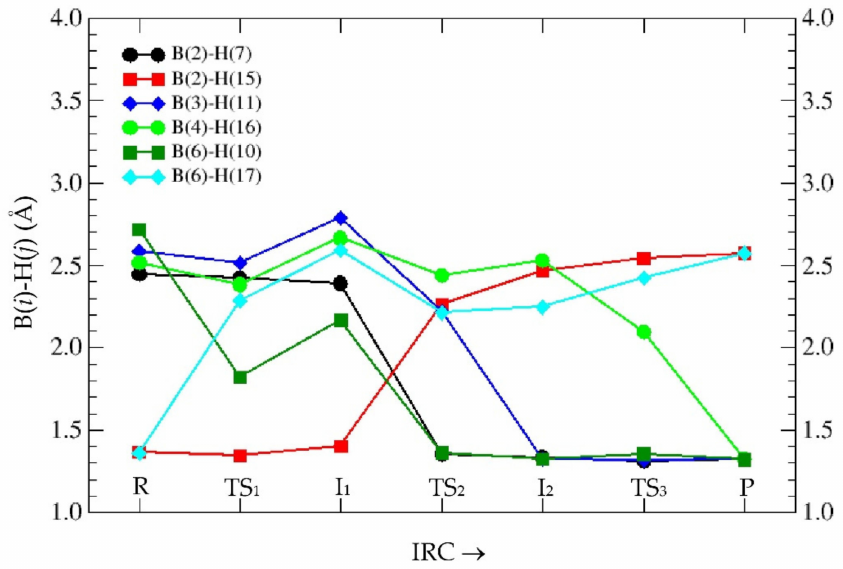
Figure 4. Selected B( i )-H( j ) distances (Å) for the Stationary Points (SP) along the R → P reaction pathway for the 3D → 2D isomerization of